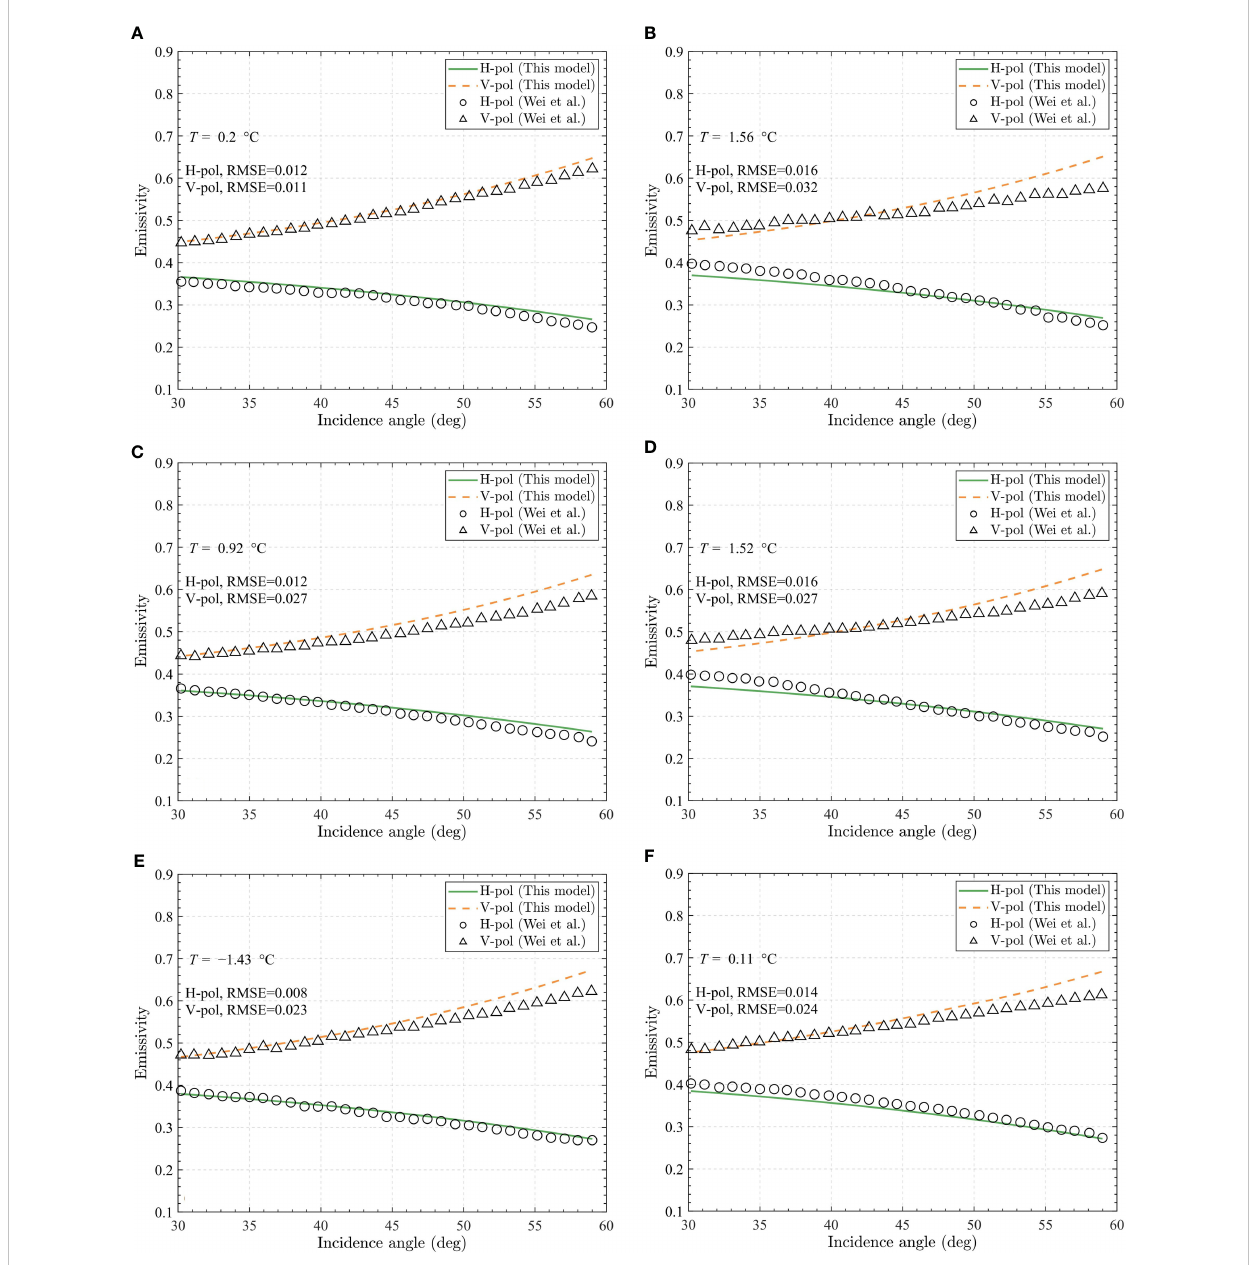
FIGURE 7 Comparison of the foam emissivity calculated with the present model to the experimental data (Wei et al., 2014, symbols) with different water properties: (A) temperature Ts = 0.20 °C salinity Ss = 31.71 psu; (B) temperature Ts =1.56°C salinity Ss = 32.50 psu; (C) temperature Ts =0.92 °C, salinity Ss= 32.76 psu; (D) temperature Ts =1.52°C, salinity Ss = 33.63 psu; (E) temperature Ts = -1.43°C, salinity Ss = 34.66 psu; (F) temperature Ts =0.11 °C, salinity Ss = 37.74